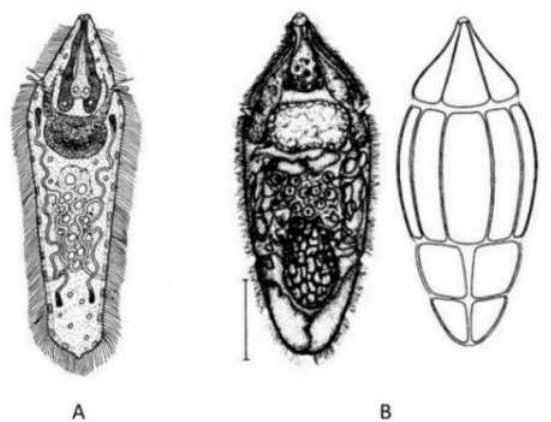
Figure 3. The morphology of miracidia. A. the general morphology of Tricho - bilharzia szidati (from [23]); B. the general morphology of Trichobil - harzia regenti (left) and the arrangement of ciliated plates (right), scale bar = 25mm (from